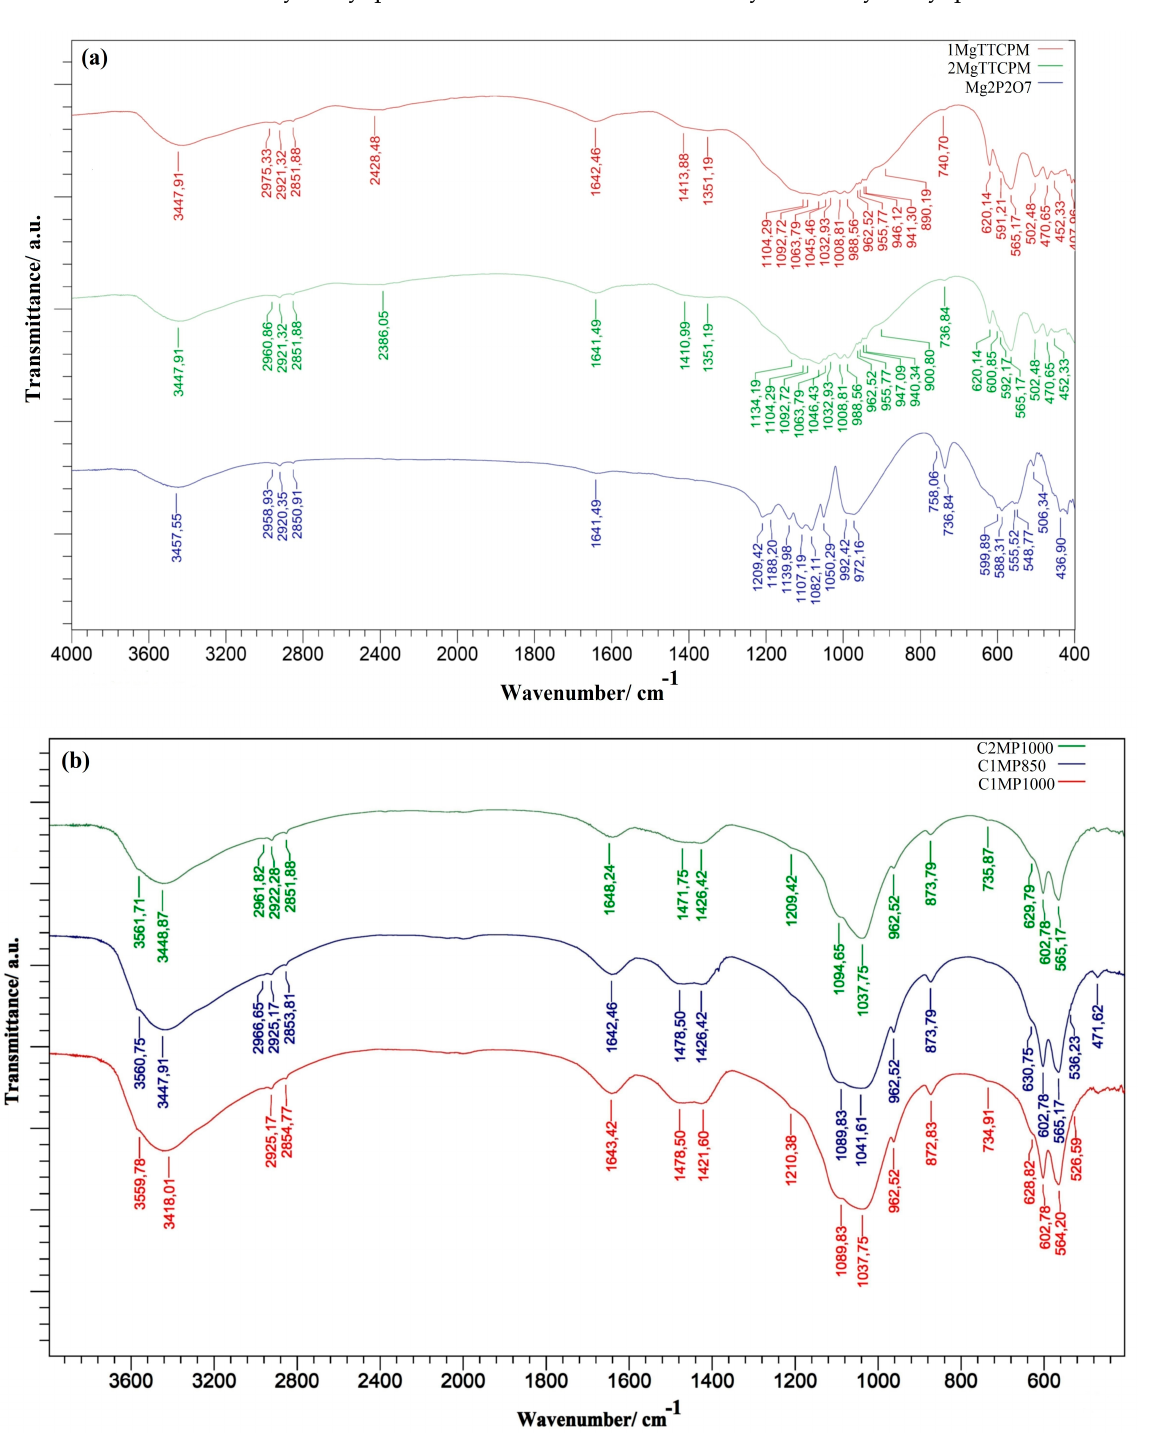
Figure 3. FTIR spectra of ( a ) 1 MgTTCPM, 2 MgTTCPM powder mixtures and Mg 2 P 2 O 7 ; ( b ) FTIR spectra of C1MP850, C1MP1000, and C2MP1000 hardened cements after 7 days soaking in SBF.